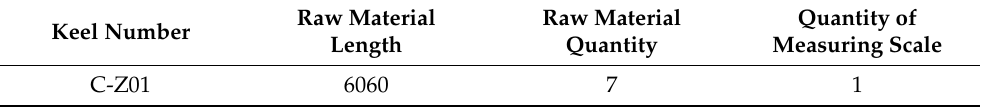
Table 11. Raw material length of the secondary curved